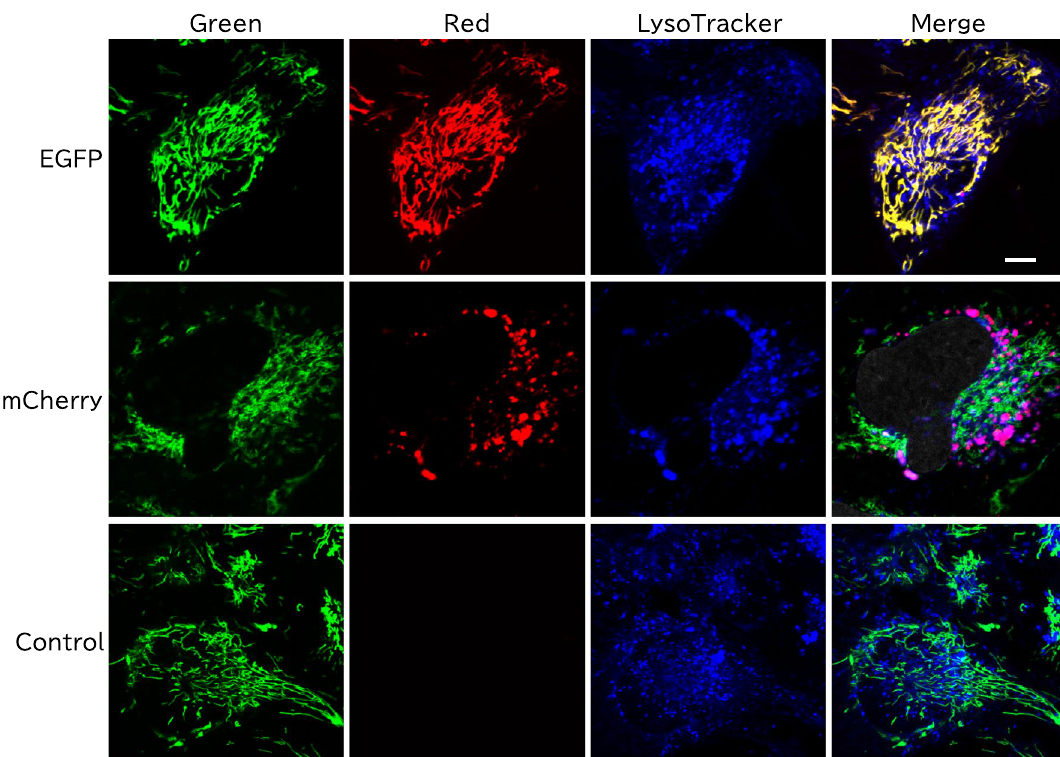
Figure 4. Colocalization of mCherry aggregates with lysosomes. Representative images of iAECs transduced with mitochondria targeting mCherry or EGFP or uninfected controls stained with MitoTracker Green (green, for mCherry and control) or Orange (red, for EGFP) and LysoTracker Deep Red (blue). Scale bar = 10